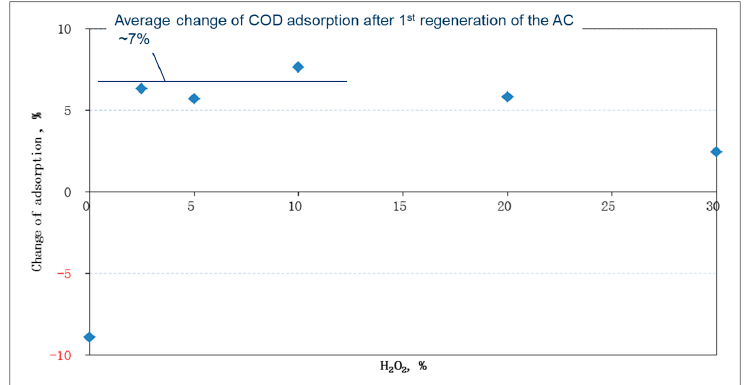
Figure 4. Plots of the changes in the AC adsorption capacity after its first regeneration at various peroxide concentrations and a fixed initial iron-complex content of 2.12 mmole/dm 3 . The results showed that the use of the initial peroxide concentration at 2.5% was sufficient to regenerate the saturated ACs.